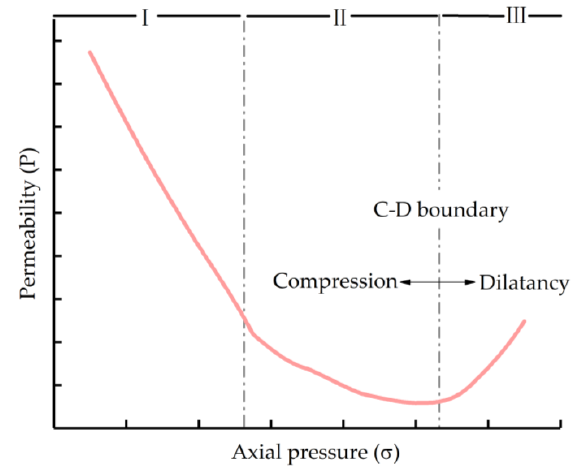
Figure 2. Change curve of the permeability coefficient during the full stress–seepage of the fractured rocks.